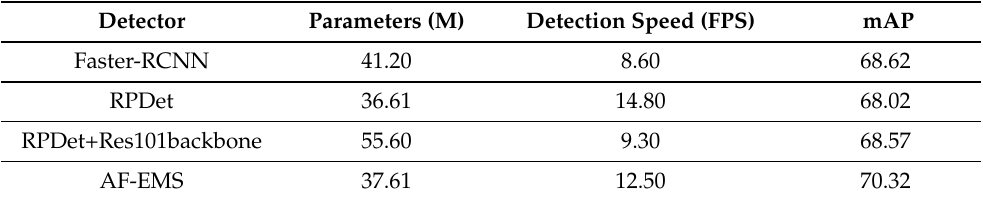
Table 5. Comparison of model size and detection speed.